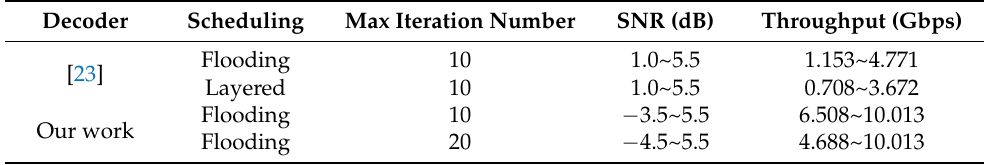
Table 5. Comparison of the throughput performance with other decoders that introduced the early termination